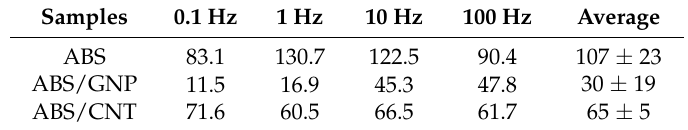
Table 1. Activation energy (E act ) in kJ/mol at various frequencies at temperature 250 and 280 ◦ C.